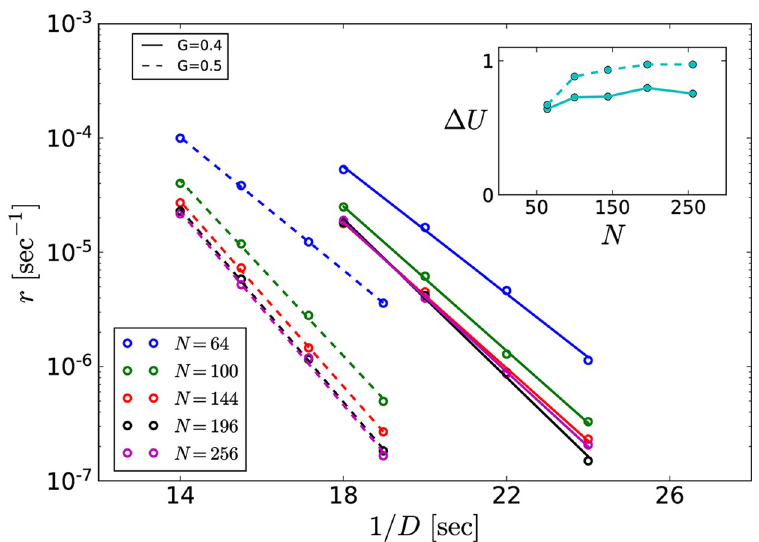
Fig 4. Arrhenius plot. Spontaneous nucleation rate as function of the inverse noise intensity obtained from four two- dimensional systems with different system sizes as indicated and periodic boundary conditions. From the linear fit of these data, an effective potential barrier Δ U and a rate prefactor r 0 can be estimated (dependence of Δ U on system size shown in inset).